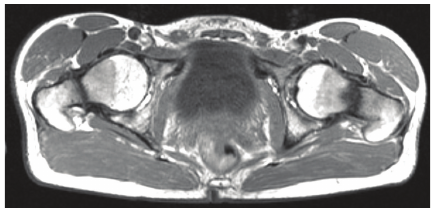
Figure 3: Axial T2-weighted MRI of the pelvis showing bilateral, atrophic nonunions of the femoral neck